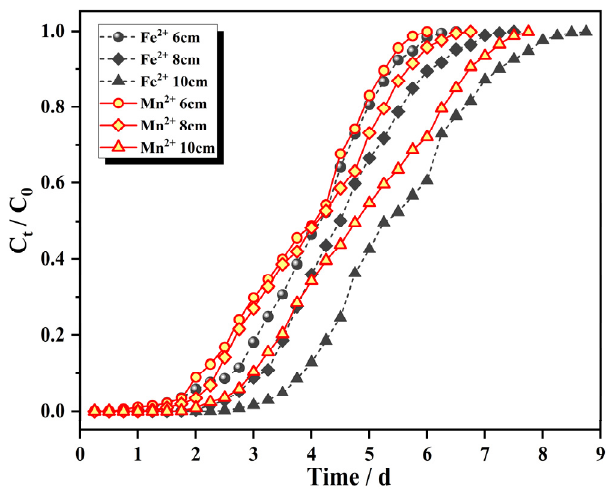
Figure 6. Micro analysis. ( a ) N 2 adsorption–desorption isotherms of TM and IHA/TM; ( b ) SEM im- ages of TM and IHA; ( c ) SEM images of IHA/TM; ( d ) EDS spectra of IHA/TM; ( e ) FTIR spectra of IHA/TM; and ( f ) XRD patterns of IHA/TM.